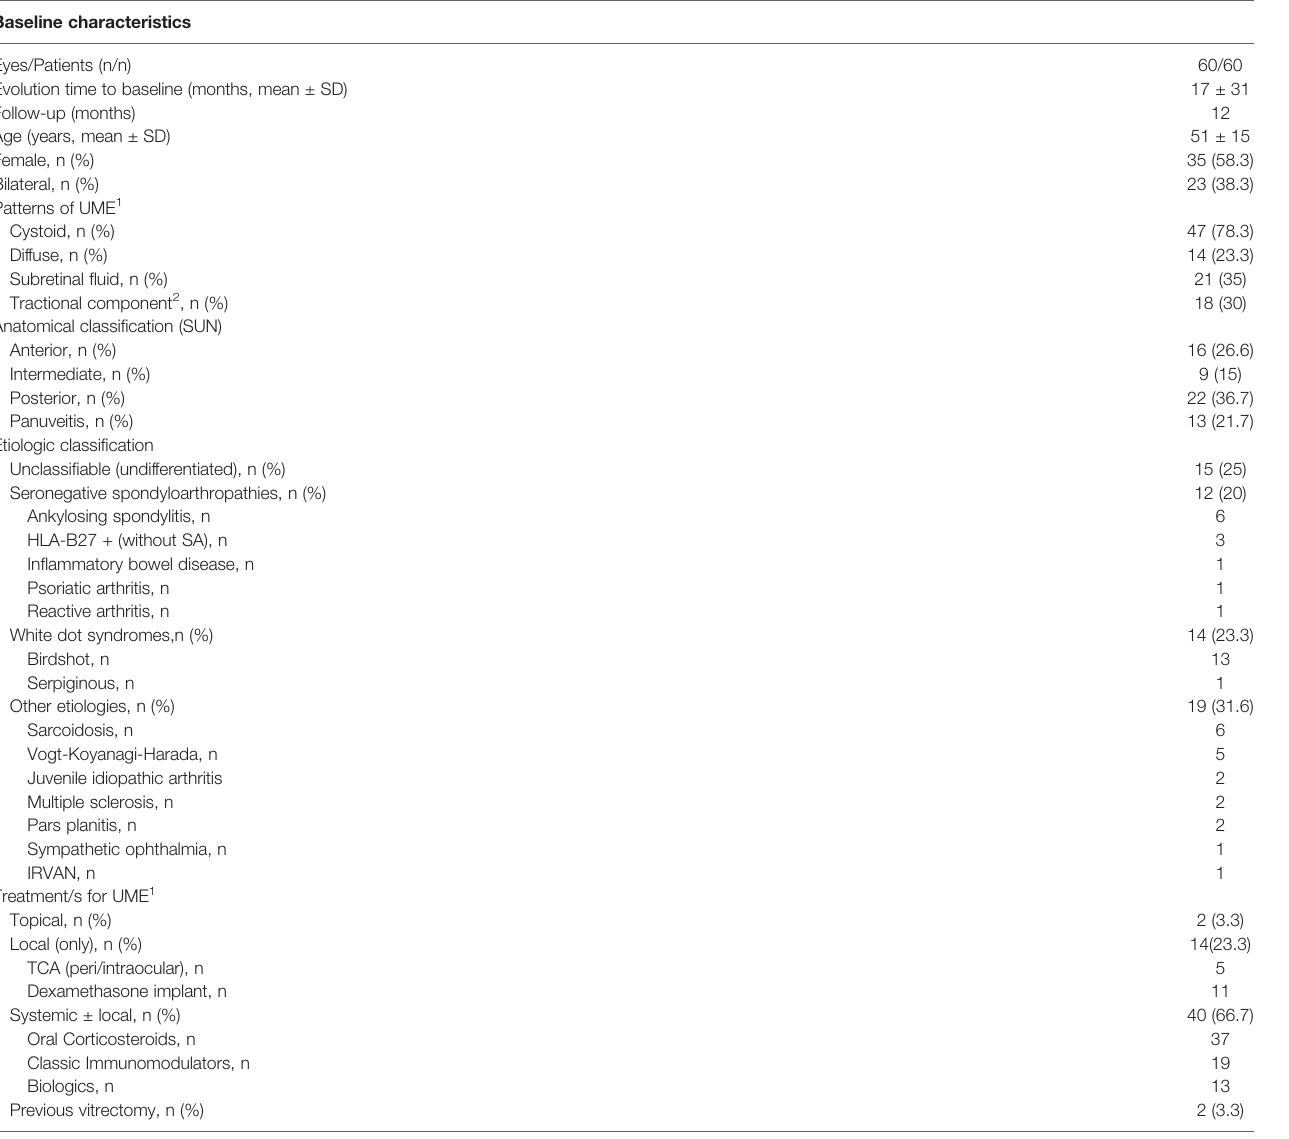
TABLE 1 | Baseline ophthalmic characteristics in eyes with uveitic macular edema. Baseline characteristics Eyes/Patients